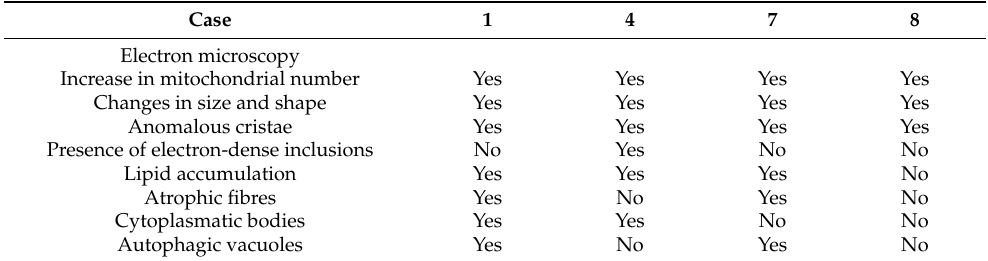
Table 2. Ultrastructural features (n = 4) in the muscle biopsies from the paediatric patients with TK2